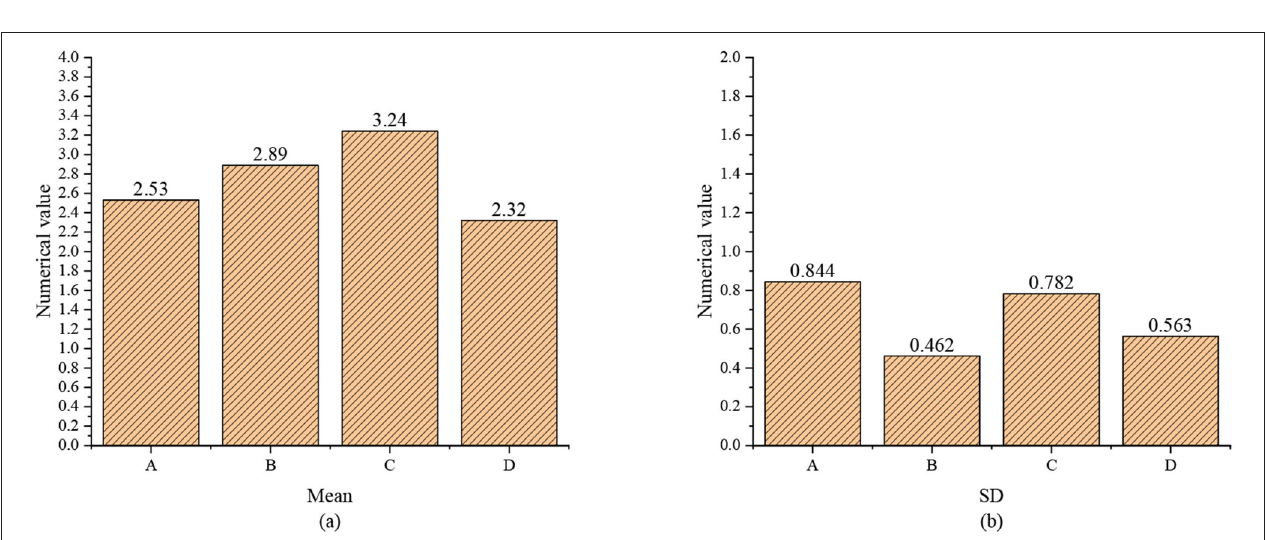
FIGURE 6 | The mean value and standard deviation of key variables (A: entrepreneurial traits; B: entrepreneurial self-efficacy; C: entrepreneurial alertness; D: entrepreneurial attitude; (a) mean value; (b) standard